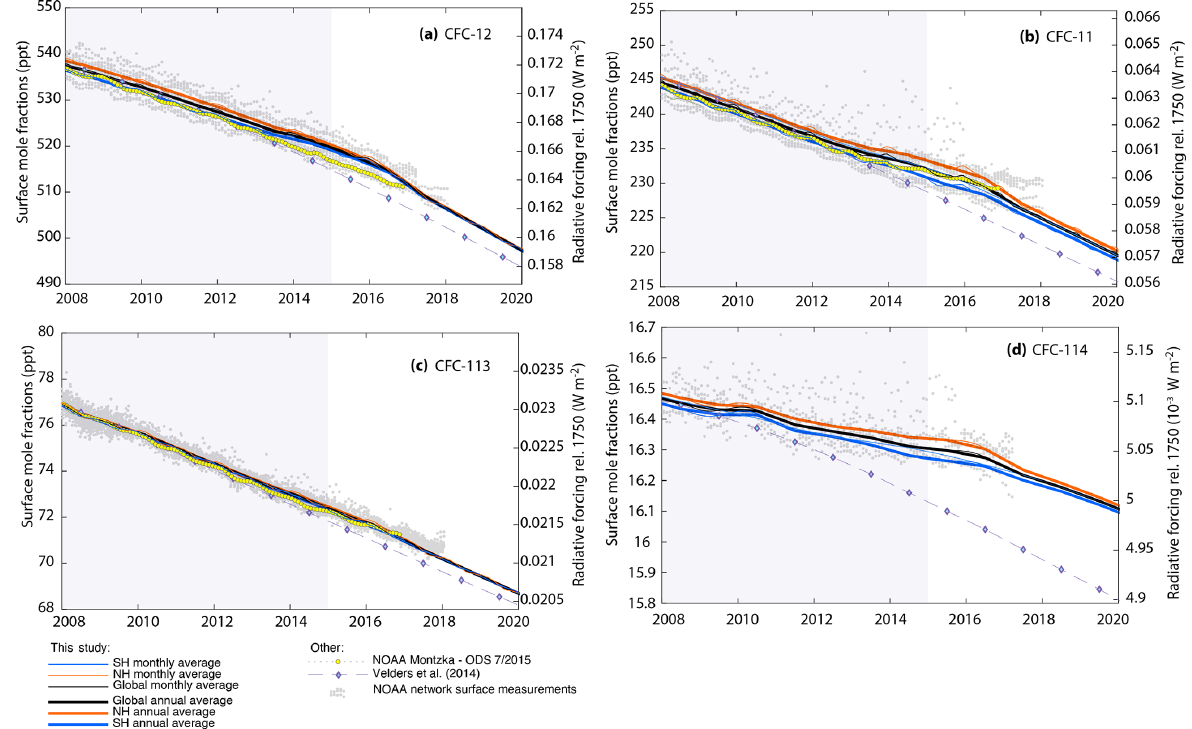
Figure 10. Atmospheric surface air mole fractions of four CFCs, namely CFC-12 (a) , CFC-11 (b) , CFC-113 (c) , and CFC-114 (d) . This study’s northern hemispheric averages (orange lines), southern hemispheric averages (blue lines), and global averages (black lines) are shown in comparison with recent measurements of the NOAA and/or AGAGE networks (grey dots), the global averages derived by Montzka et al. (2018), and the projections by Velders and Daniel (2014) (dashed lines with diamond markers). The latter can be seen as near-lifetime limited projections, whereas observations hint at recent (since 2012) emissions increases, leading to a slower-than-projected fall in global atmospheric concentrations. For an exploration of CFC-11’s decline rates, see the recent studies by Montzka et al. (2018) and Rigby et al. (2019). Note that the high “outlier” monthly mean values for CFC-11 and CFC-114 are primarily from the AGAGE Gosan station and include all data, i.e. so-called “pollution” events, in which case temporary high-concentration air masses pass the measurement station. The apparent disappearance of those high-pollution events at the end of 2015 is due to that particular AGAGE data time series only having been available until then at the point of this analysis, although a recent publication (Rigby et al., 2019) shows that these enhancements continued at least through